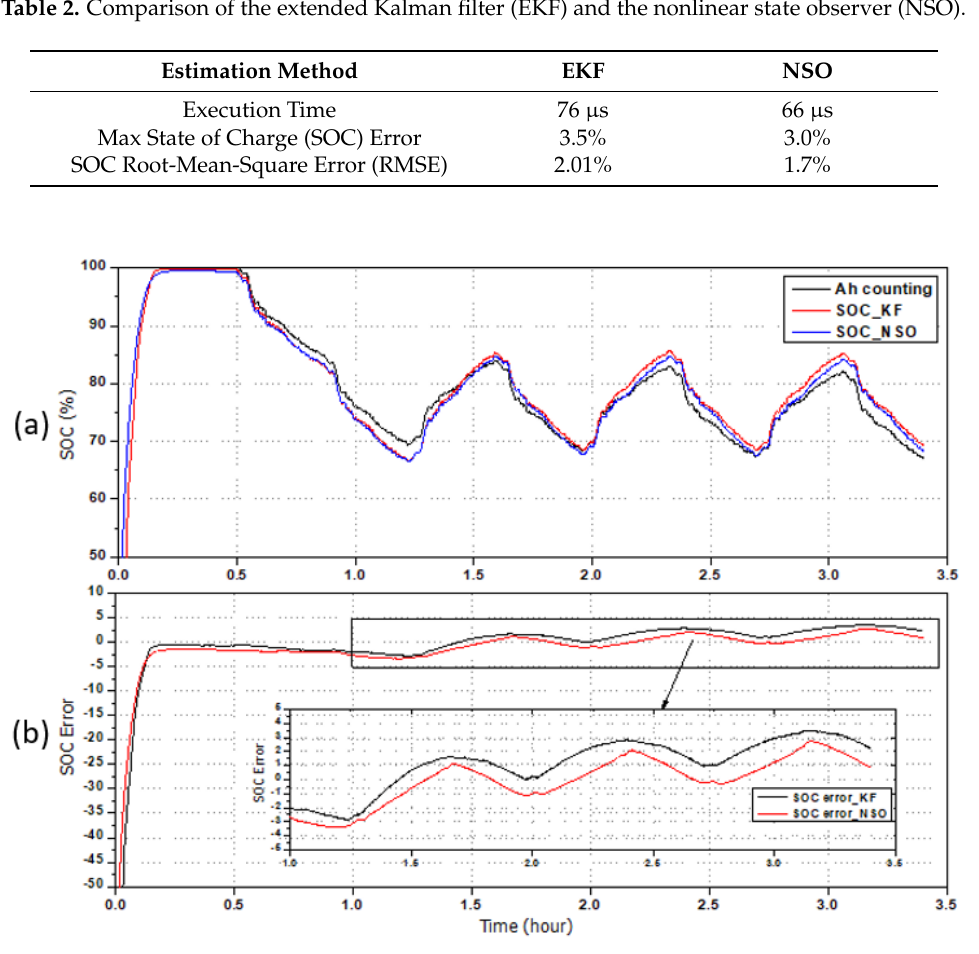
Figure 4. ( a ) SOC estimation results using the extended Kalman filter (EKF) and the nonlinear state observer (NSO). ( b ) SOC errors using the EKF and the NSO.